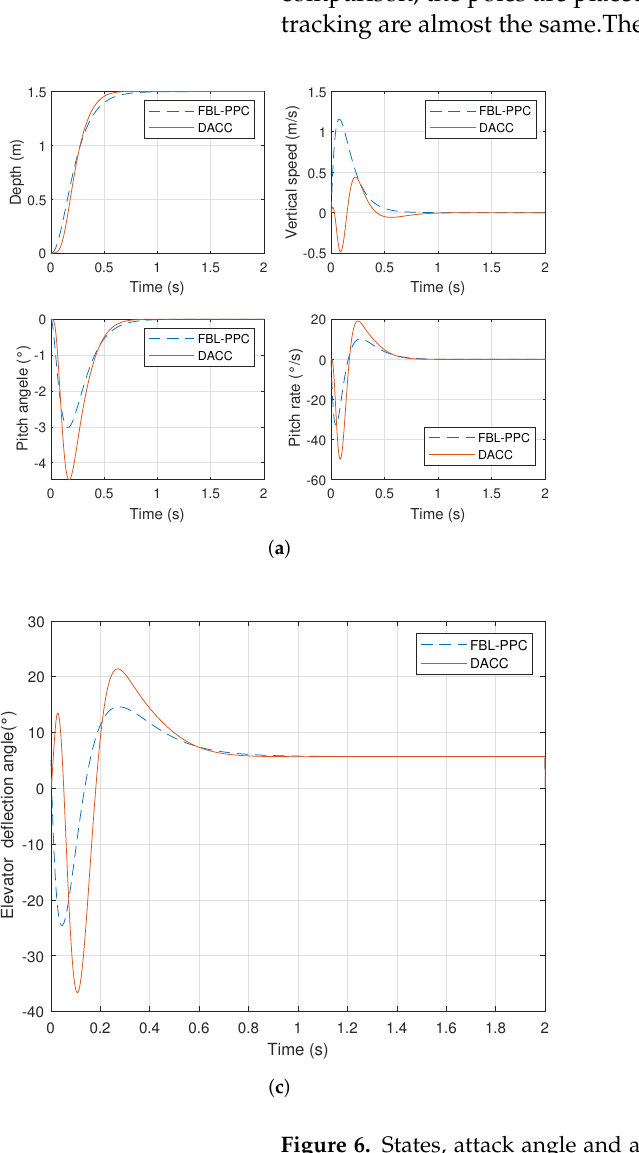
Figure 6. States, attack angle and actuator deflections comparison of the supercavitating vehicle with the DACC and feedback linearization and pole placement control(FBL-PPC): ( a ) Four states comparison; ( b ) Attack angle comparison; ( c ) Elevator deflection angle comparison; ( d ) Cavitator deflection angle